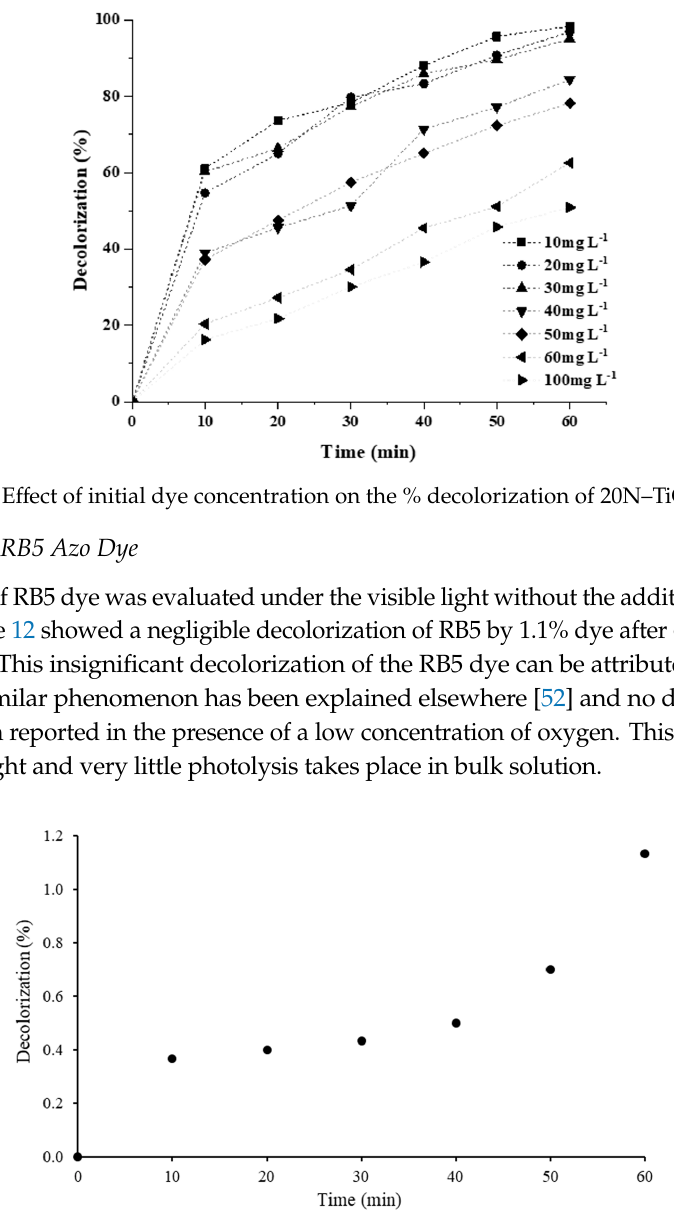
Figure 12. Photostability of the RB5 azo dye .